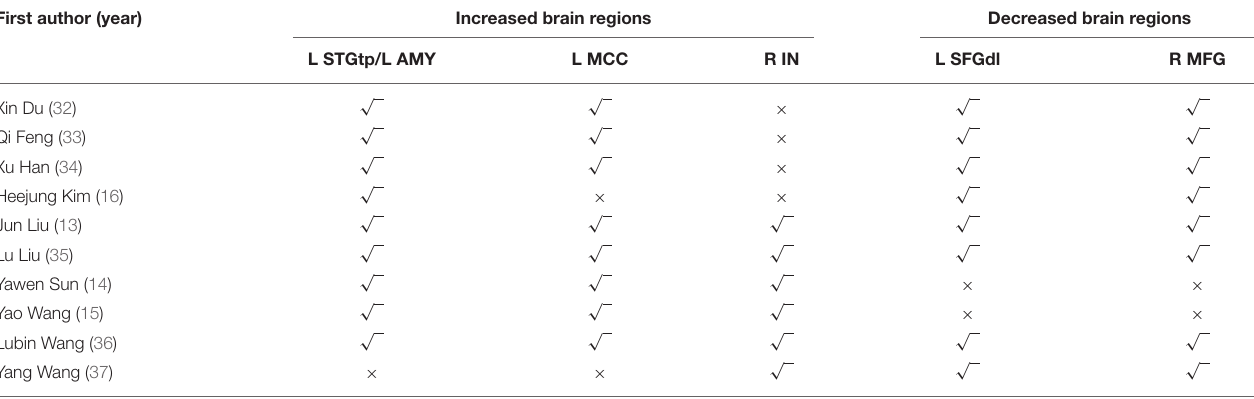
TABLE 4 | Results of sensitivity analysis of